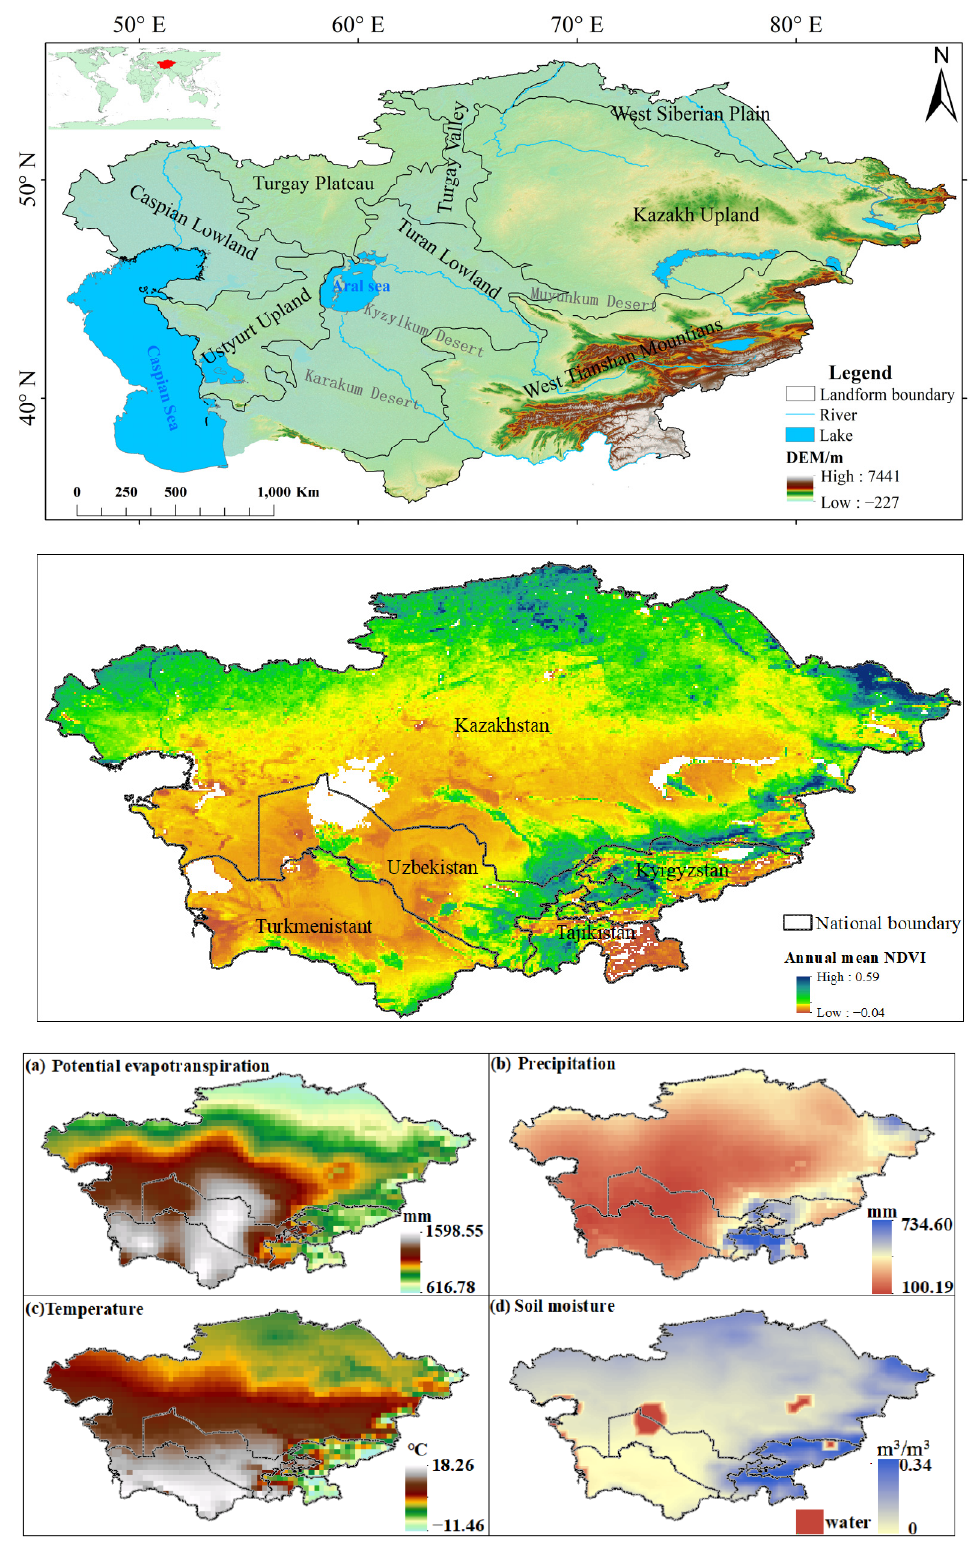
Figure 1. Topographic map of Central Asia and spatial distribution of annual mean value of NDVI and climate factors 1982–2015. (National boundary data was acquired from the National Administration of Surveying, Mapping, and Geoinformation (No. GS (2016) 2948)).